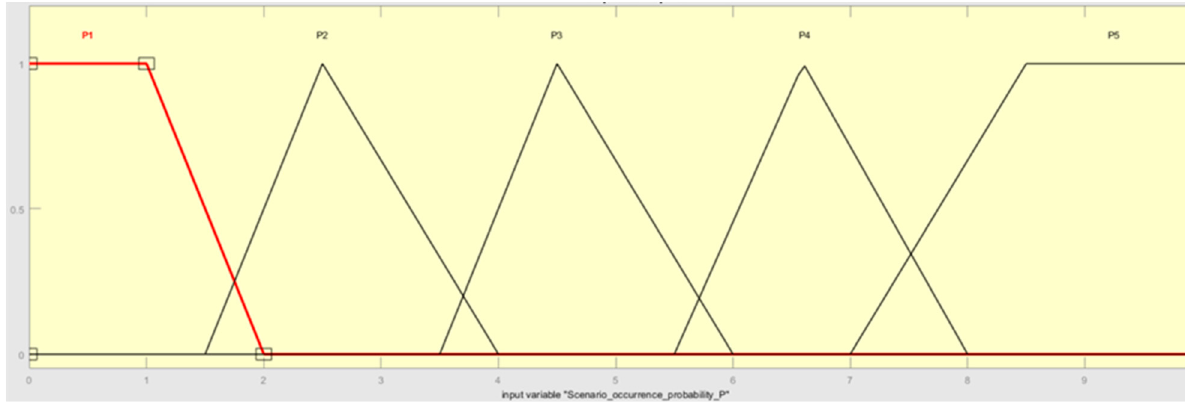
Figure 6. The scenario occurrence probability fuzzy sets.